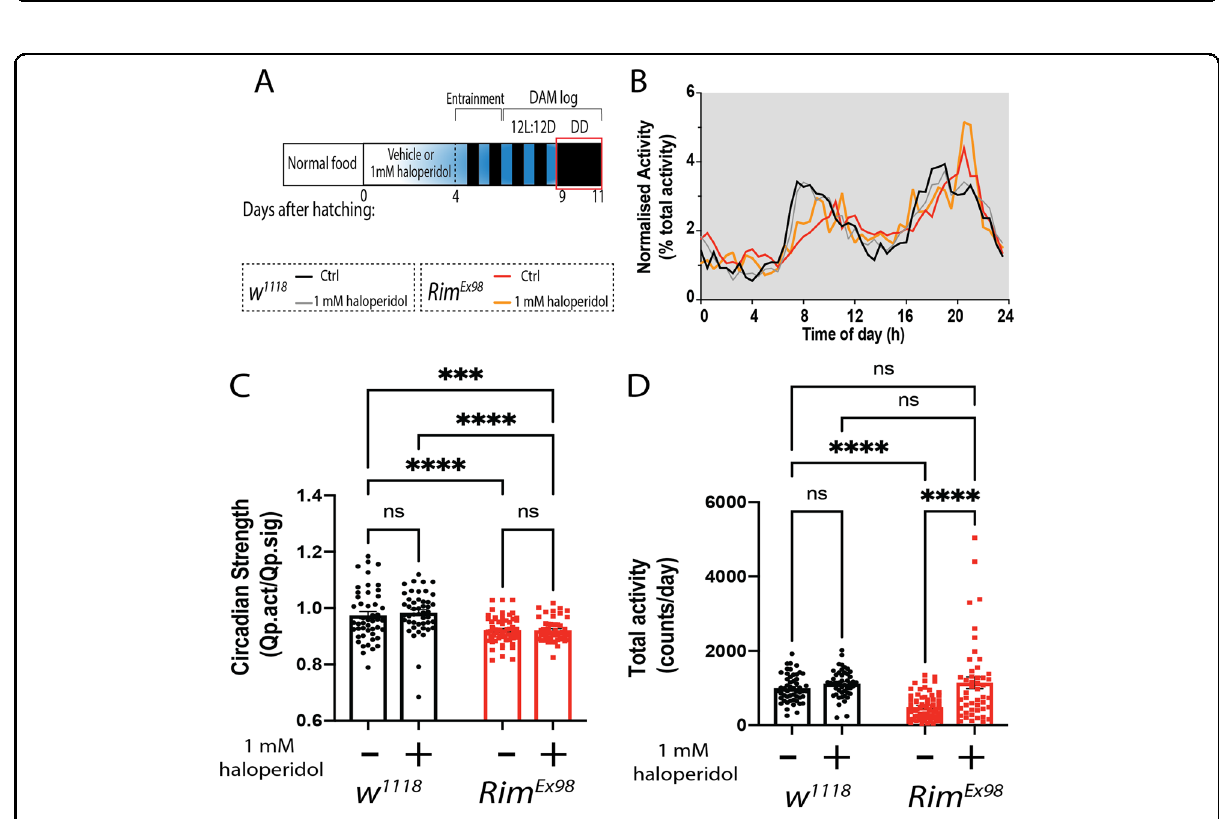
Fig. 7 Haloperidol treatment rescues total locomotor activity but not rhythmicity recorded in constant darkness in Rim mutants. A Newly eclosed fl ies fed with haloperidol (1 mM) were entrained for 2 days in 12:12 LD cycles, followed by 3 days in LD and 2 days in DD, where locomotor circadian activity was measured (red box). B Normalized averaged activity pro fi les of w 1118 fl ies fed with normal (black line) and 1 mM haloperidol- supplemented food (grey line), and Rim Ex98 fl ies fed with normal (red line) and haloperidol-supplemented food (orange line), in DD conditions. C Circadian strength was reduced in Rim Ex98 fl ies compared to control fl ies fed with normal food. Haloperidol treatment did not change the circadian strength of w 1118 or Rim Ex98 . D The average locomotor activity between the 2 days in DD was quanti fi ed as counts (beam breaks) per day for each fl y. Rim Ex98 mutants displayed a reduction in total locomotion compared to w 1118 fl ies in normal food. This decrement was absent in Rim Ex98 fl ies fed with haloperidol, being rescued to levels indistinguishable from control fl ies. Data were analysed using two-way ANOVA with Sidak ’ s post hoc test n ( w 1118 Ctrl) = 59 fl ies, n ( w 1118 1 mM haloperidol) = 50 fl ies, n ( Rim Ex98 Ctrl) = 88 fl ies and n ( Rim Ex98 1 mM haloperidol) = 48 fl